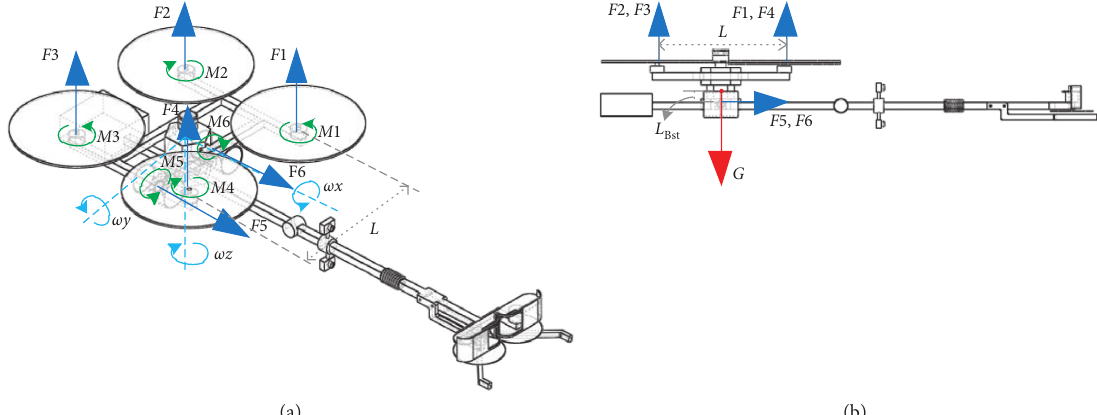
Figure 1: The inputs and moments of the aerial tree-pruning robot.